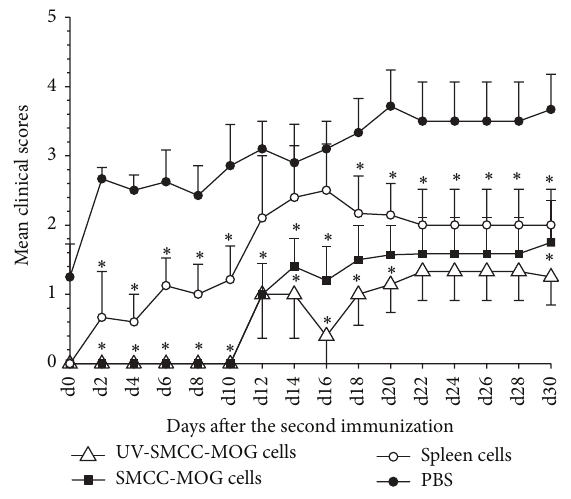
Figure 3: MOG-SPs treated mice develop significantly delayed and ameliorated EAE upon MOG challenge. Prevention experi- ments were performed as shown in Figure 1. EAE reinduction was performed 63 days after the first induction (10 mice/group). EAE development was monitored daily until day 30 after the second EAE induction. The scores of treatment groups were compared with the scores of PBS treated group at each time point. ∗ 𝑝 < 0.05 . Data shown were from a representative of three independent experiments.